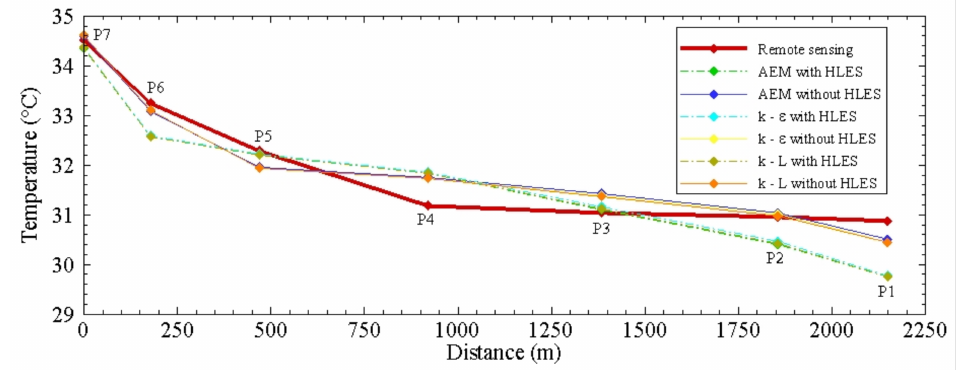
Figure 9. Simulated decay temperature curves following the monitoring points P1 to P7, after the calibration and validation process with the RS